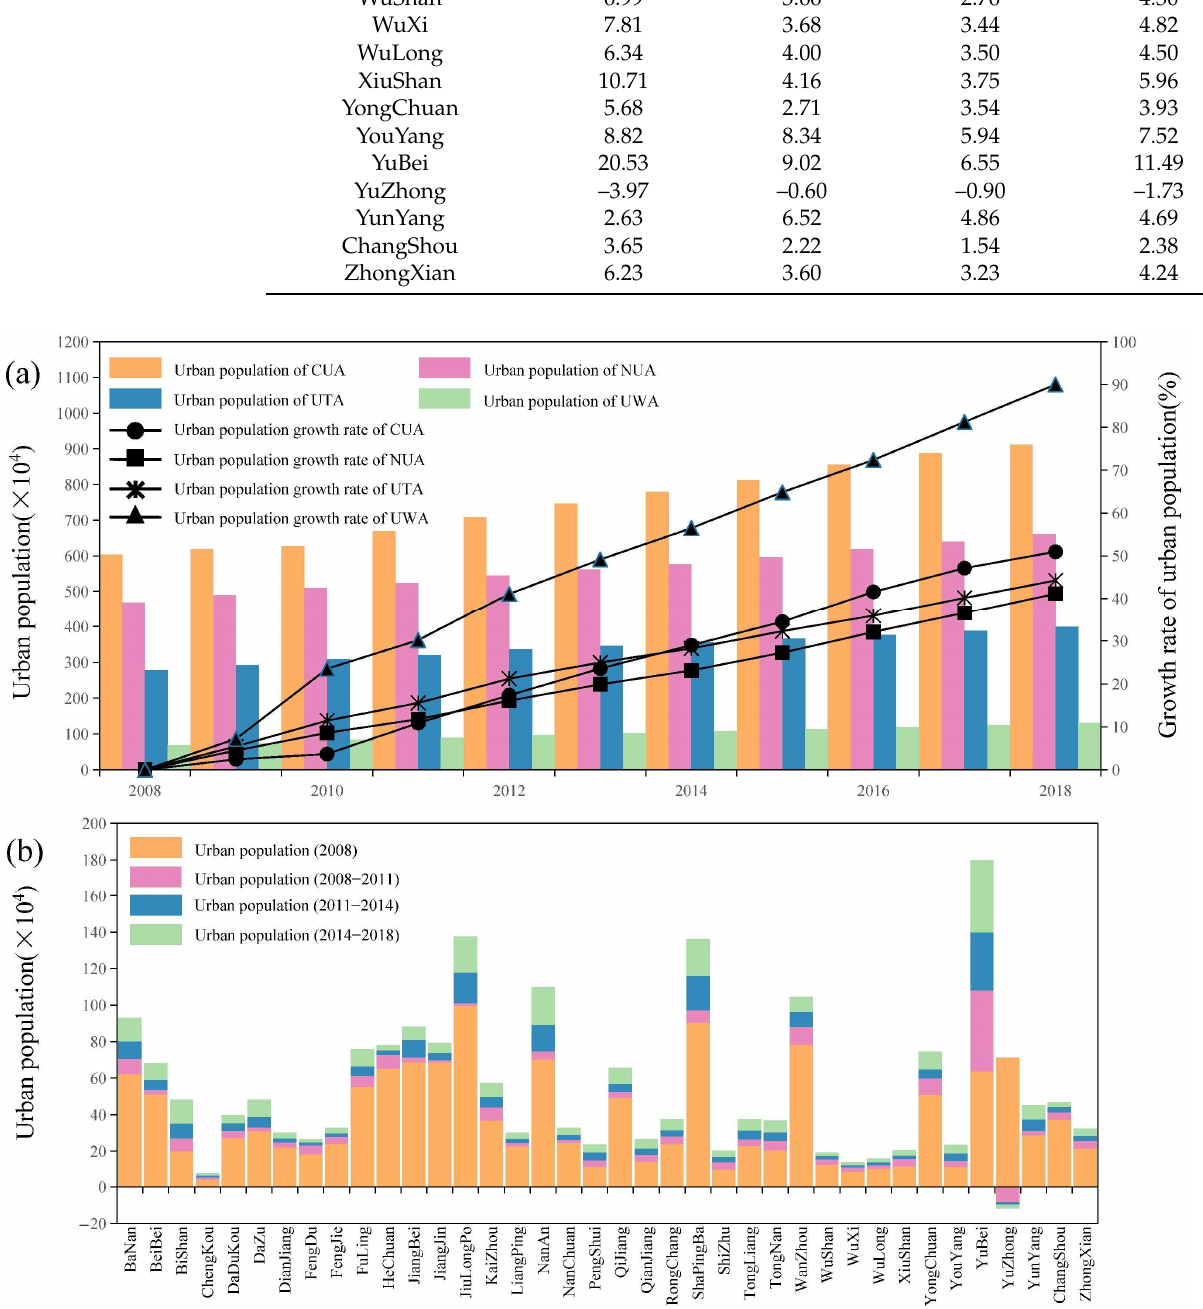
Figure 8. Spatial–temporal changes in the urban population in Chongqing during 2008–2018. ( a ) Total amount and growth rate of the urban population in Chongqing’s OATG area (CUA, NUA, UTA, and UWA) during 2008–2018. Note: The growth rate is based on 2008. ( b ) The total urban population in the 38 districts and counties of Chongqing in 2008 and the urban population growth during 2008–2011, 2011–2014, and 2014–2018.